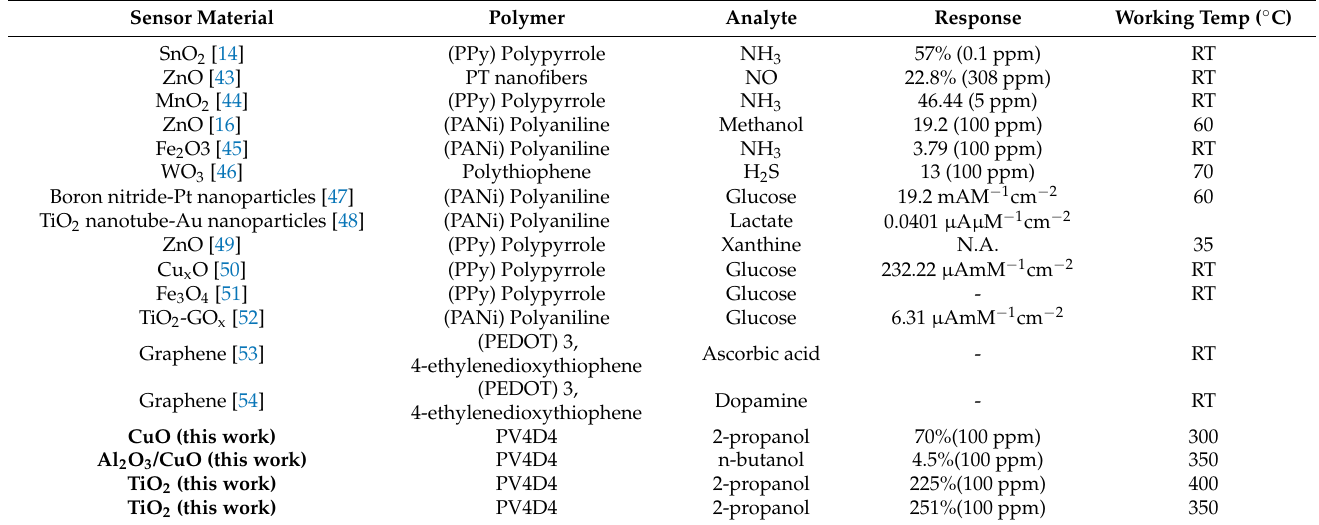
Table 2. Comparison of sensors based on conducting polymer/metal oxide hybrids and gas sensors based on the dielectric iCVD PV4D4/metal oxide hybrids studied in this